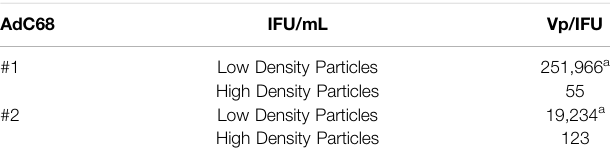
TABLE 2 | Infectivity of both the low/high density viral particle fractions for AdC68 #1 and #2.